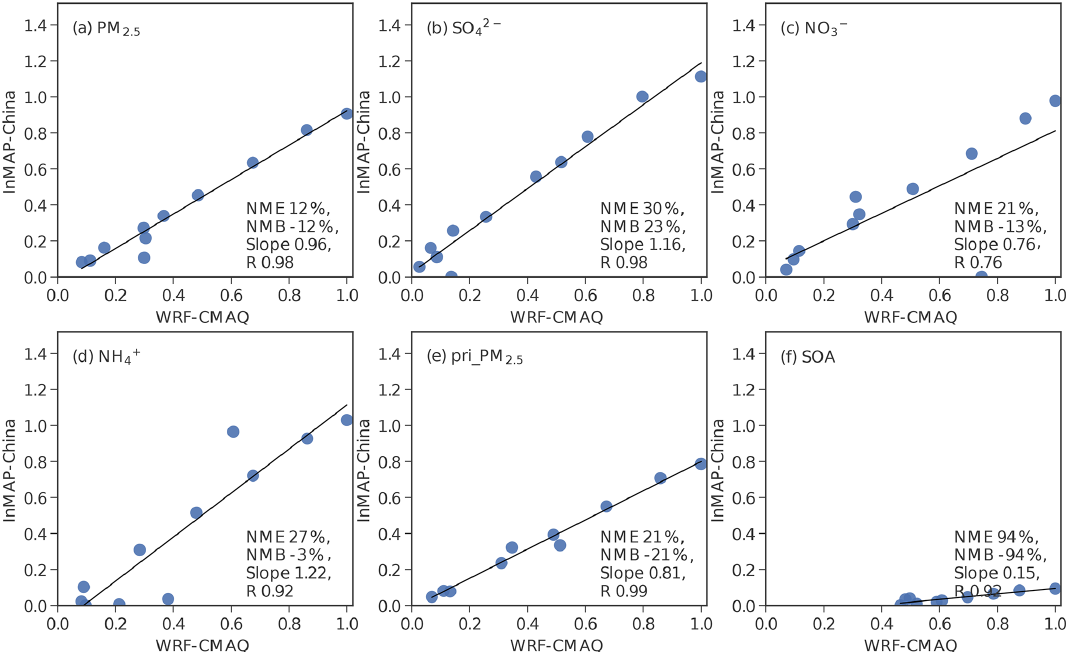
Figure 8. Marginal change in the nationwide annual average population-weighted PM 2 . 5 concentration and its composition as modeled by InMAP-China and WRF-CMAQ for 11 emission scenarios. The population-weighted pollutant concentration for each scenario is normalized using the largest value among all scenarios modeled by CMAQ. The 11 dots represent the 11 scenarios, and the statistical metrics are given in the lower right-hand corner of each panel.